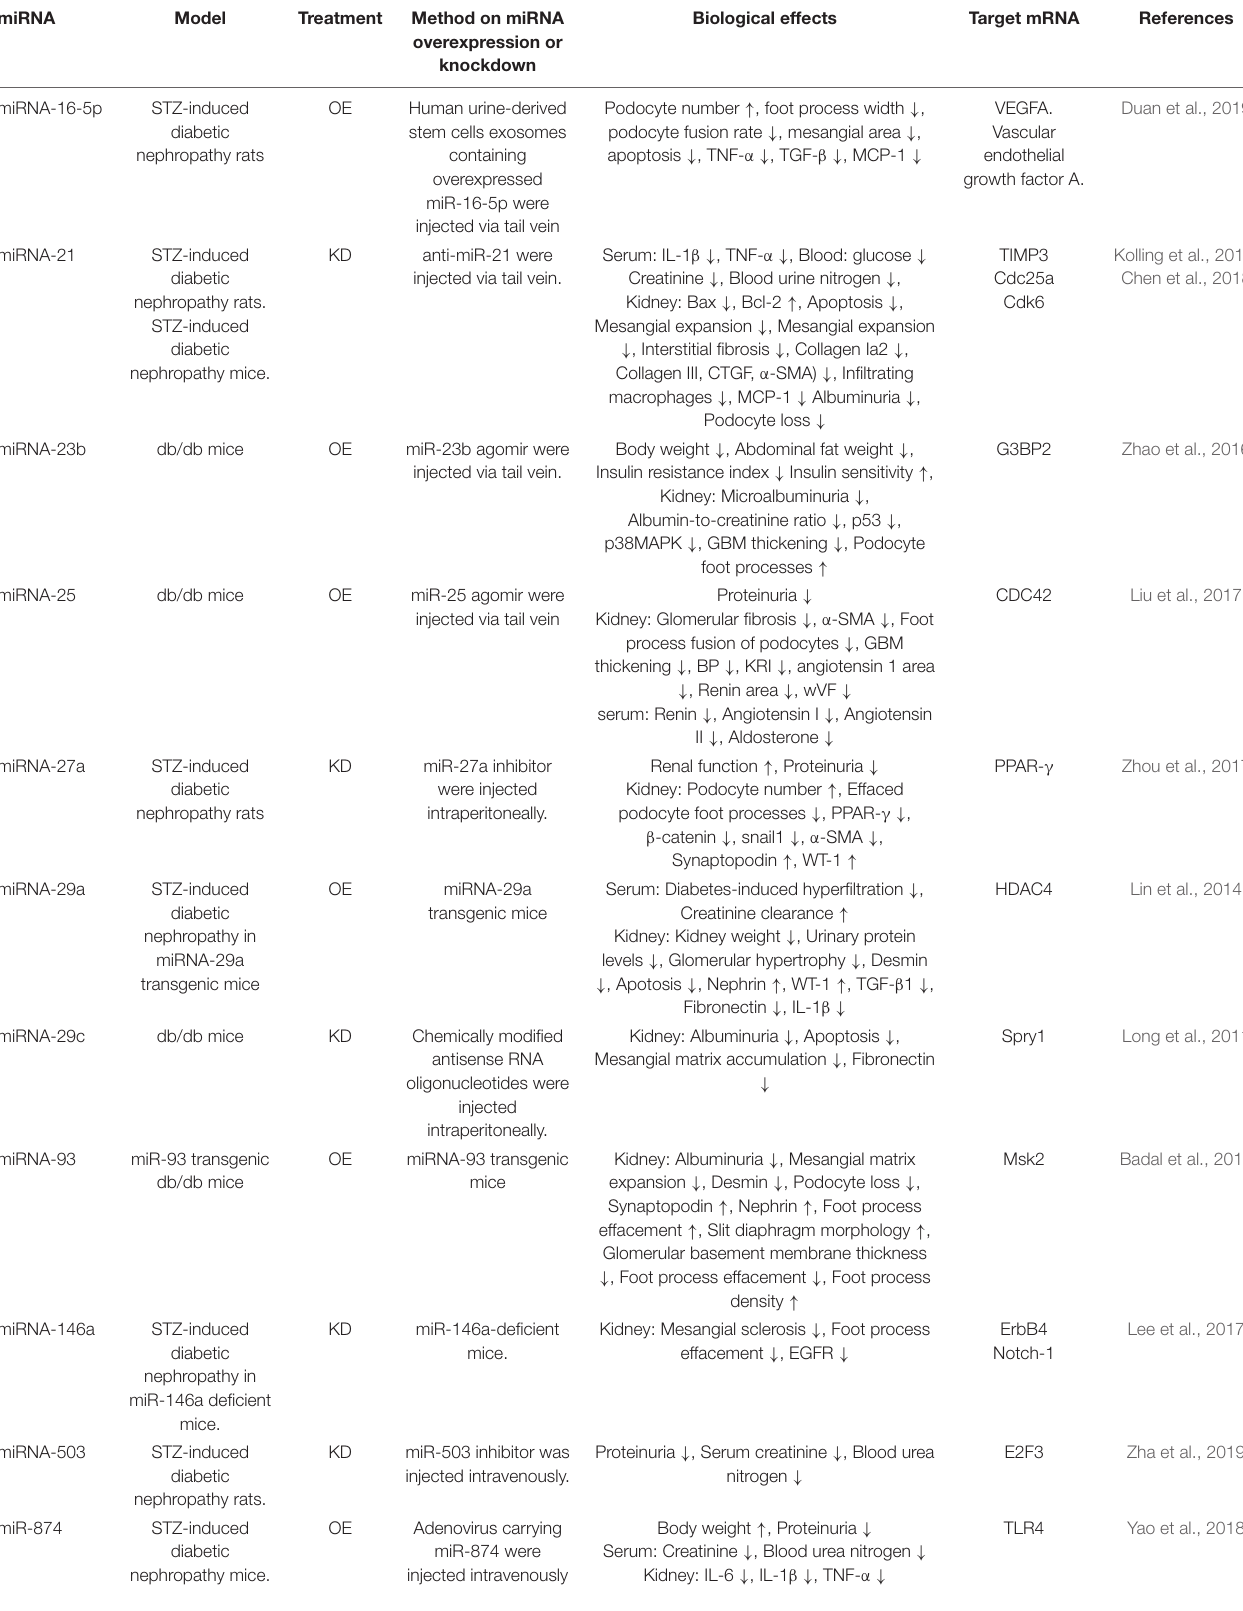
TABLE 3b | Effects of changes of miRNA expression levels on podocyte injury in diabetic nephropathy in vivo .